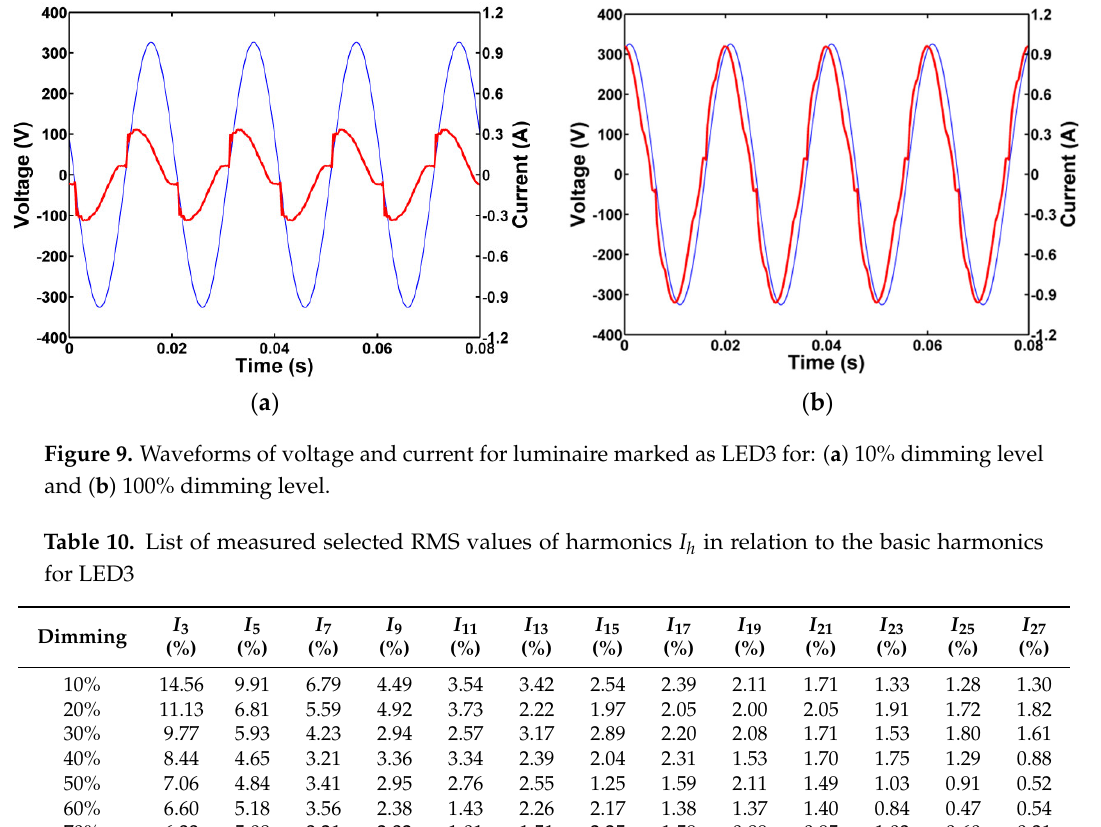
Table 10. List of measured selected RMS values of harmonics I h in relation to the basic harmonics for LED3